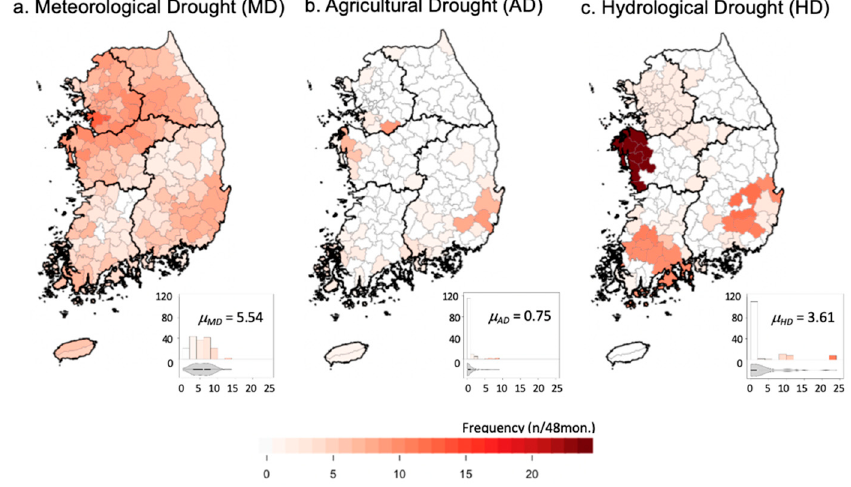
Figure 2. The number of monthly drought forecasts and warnings issued from 2017–2020.